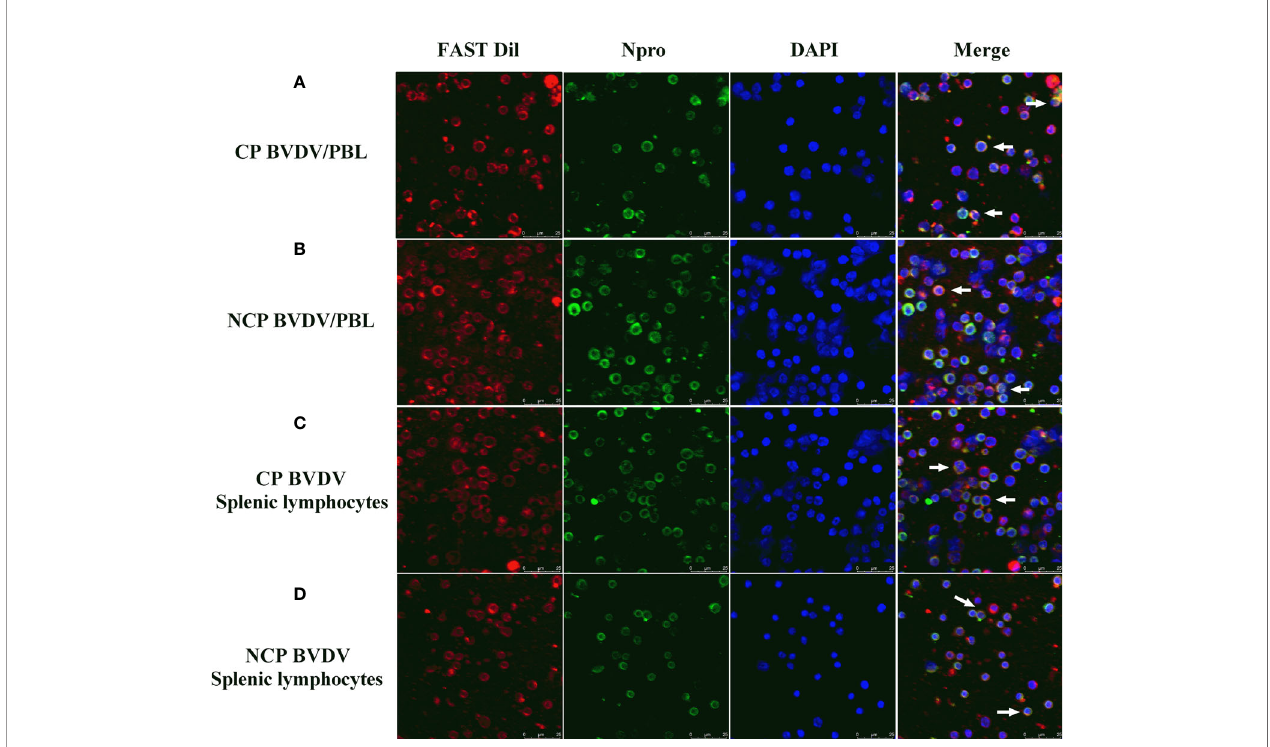
FIGURE 3 | CLSM analysis of virus-infected PBL and splenic lymphocytes at day 7 of post-infection. (A) CLSM analysis of CP BVDV-infected PBL. (B) CLSM analysis of NCP BVDV-infected PBL. (C) CLSM analysis of CP BVDV-infected splenic lymphocytes. (D) CLSM analysis of NCP BVDV-infected splenic lymphocytes. The green color denotes BVDV Npro, the red color denotes the cell membranes and the blue color denotes DAPI. Scale bar: 25 m m.